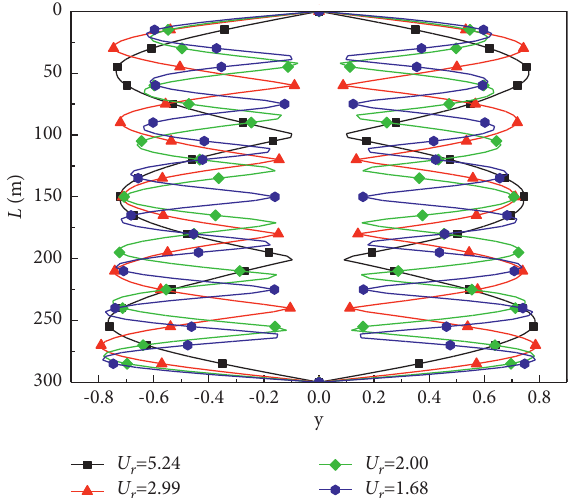
Figure 11: The VIV amplitude envelope of risers under different reduced velocities.